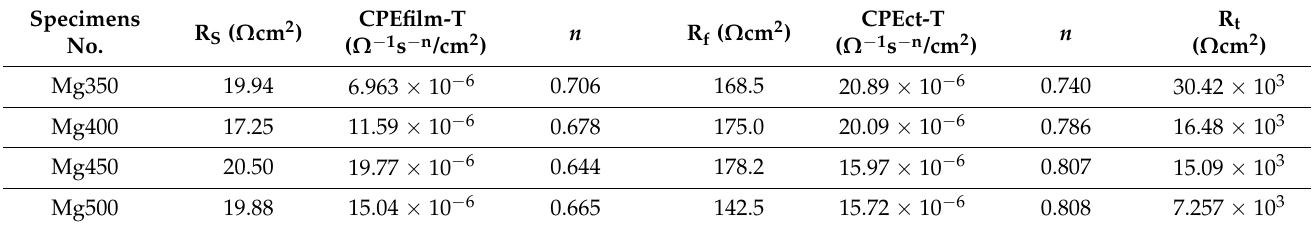
Figure 6. An equivalent circuit for impedance data fitting. Table 2. The parameters obtained from the simulation circuit in Hank’s